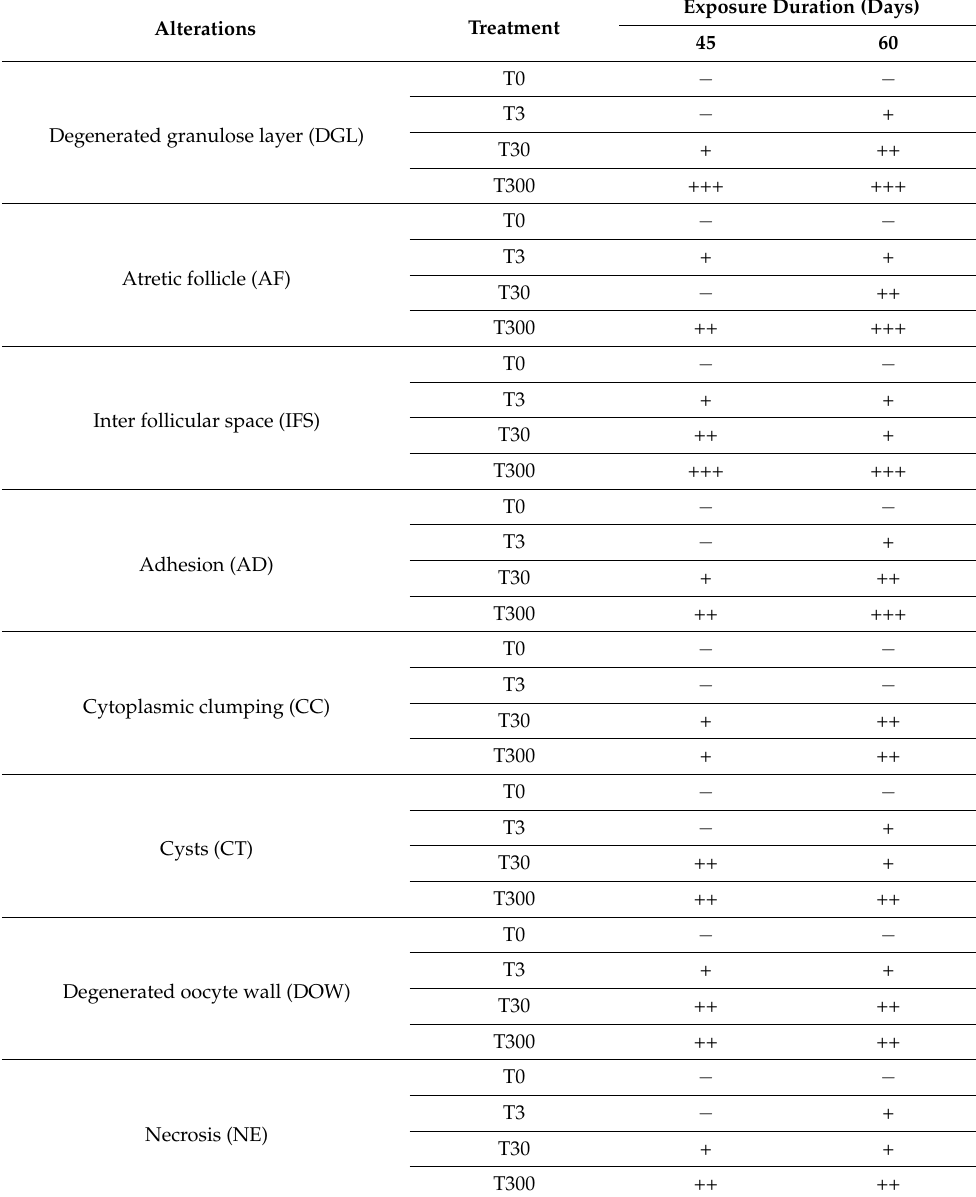
Table 2. Summary of histopathological alterations of climbing perch ovaries exposed to different concentrations of ethinylestradiol/desogestrel